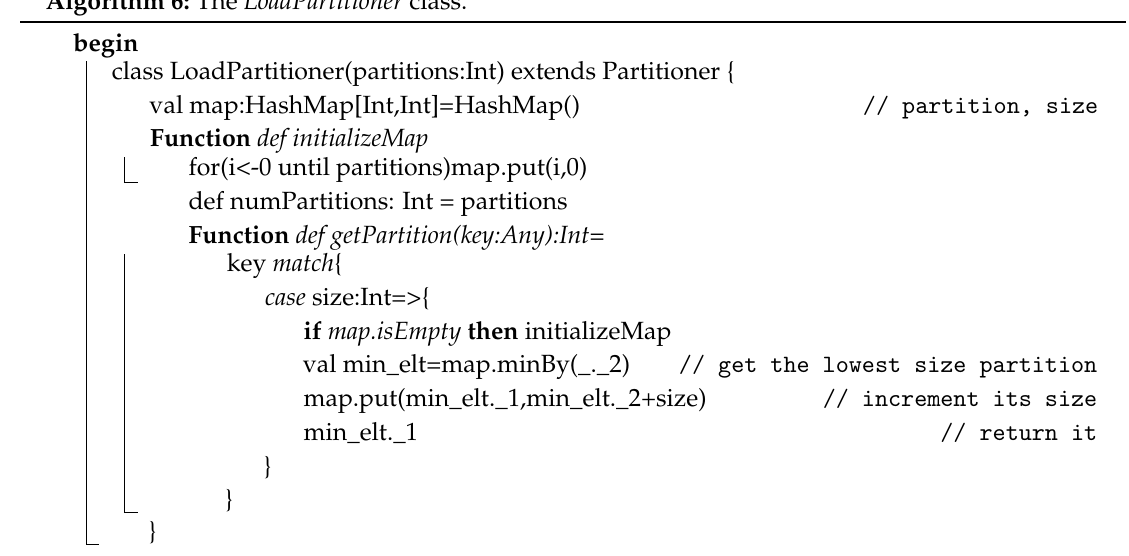
Algorithm 6: The LoadPartitioner